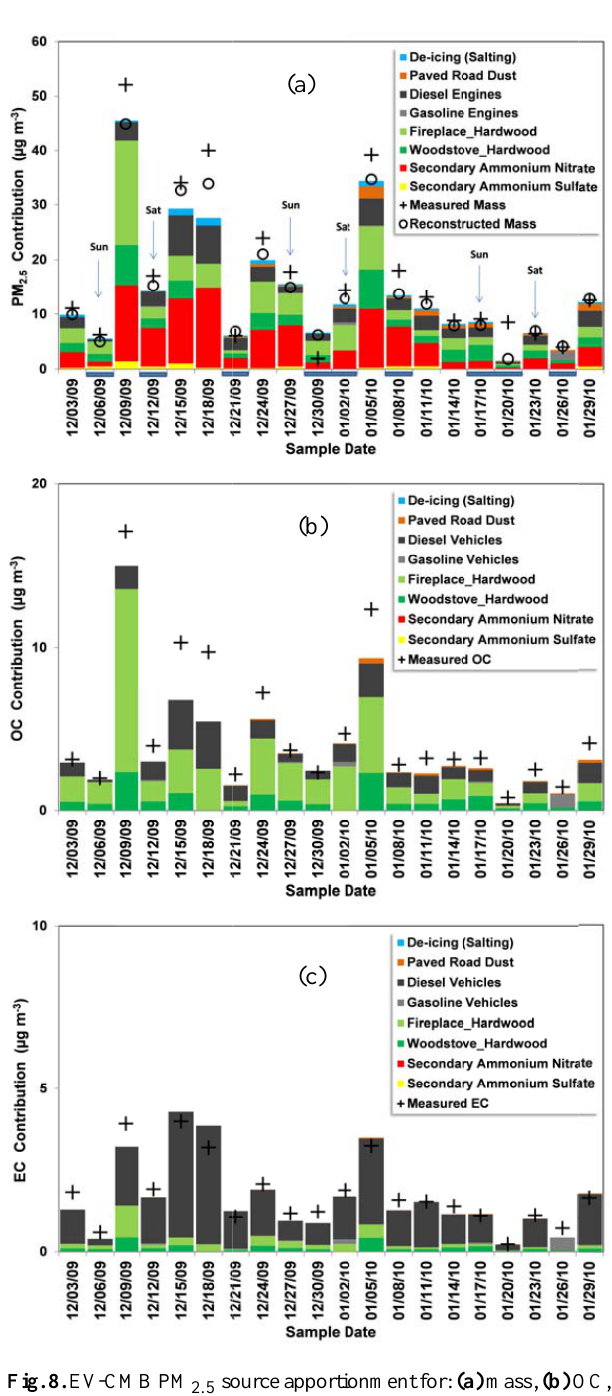
Fig. 8. EV-CMB PM 2 . 5 source apportionment for: (a) mass, (b) OC, and (c) EC. Stacked columns indicate model estimates, which are compared with measured and reconstructedmass concentrations. Weekends are noted in (a) . Snowy days are marked by a blue bar under the column in (a) . Snow cover typically accumulates during or after the snowfall.